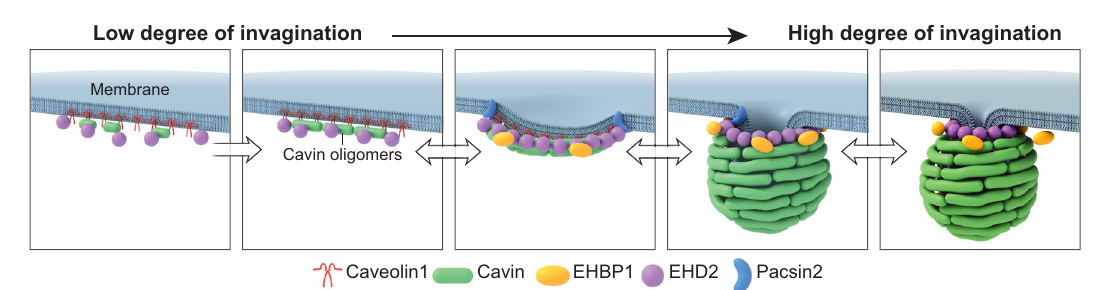
Fig. 9 | Caveolae formation and bending at the plasma membrane. Schematic model of caveolae formation and bending of the caveolae core